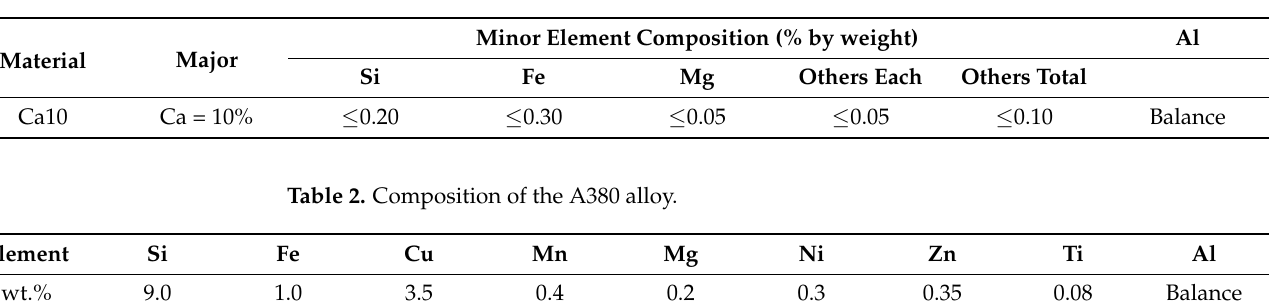
Table 1. Composition of the master alloy.